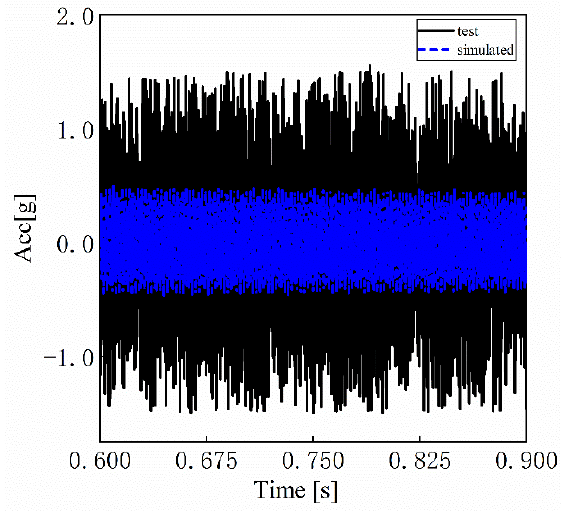
Figure 10. Time domain diagram of vibration acceleration of the helical gear in normal state.